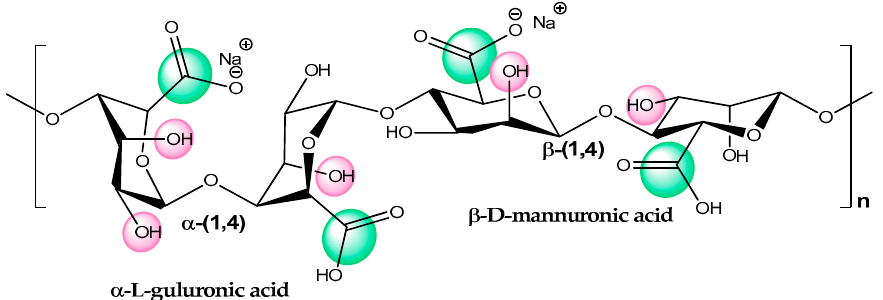
Figure 17. Schematic representation of the chemical structure of sodium alginate. The highlighted groups (aqua = carboxyl and light pink = hydroxyl) represent the sites that can be chemically modified.